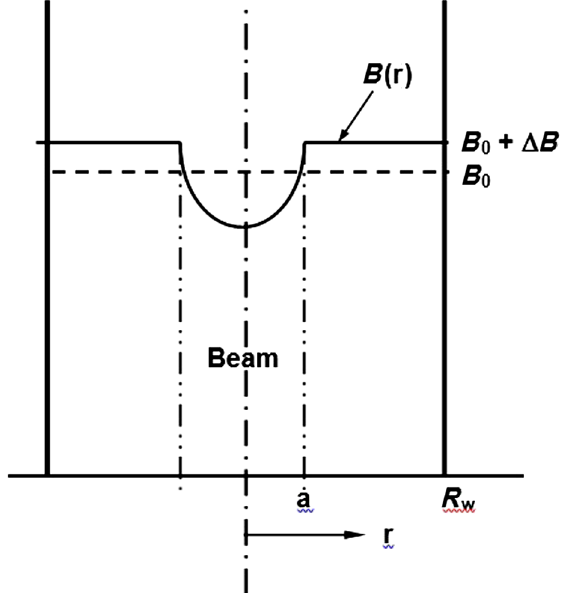
FIG. 1. Magnetic fields inside diamagnetic loop diagnostic. B 0 is the field prior to the arrival of the beam. The field is depressed inside the beam by its diamagnetism. Outside of the beam, the field is increased by Δ B to conserve flux (Adapted from Ref.